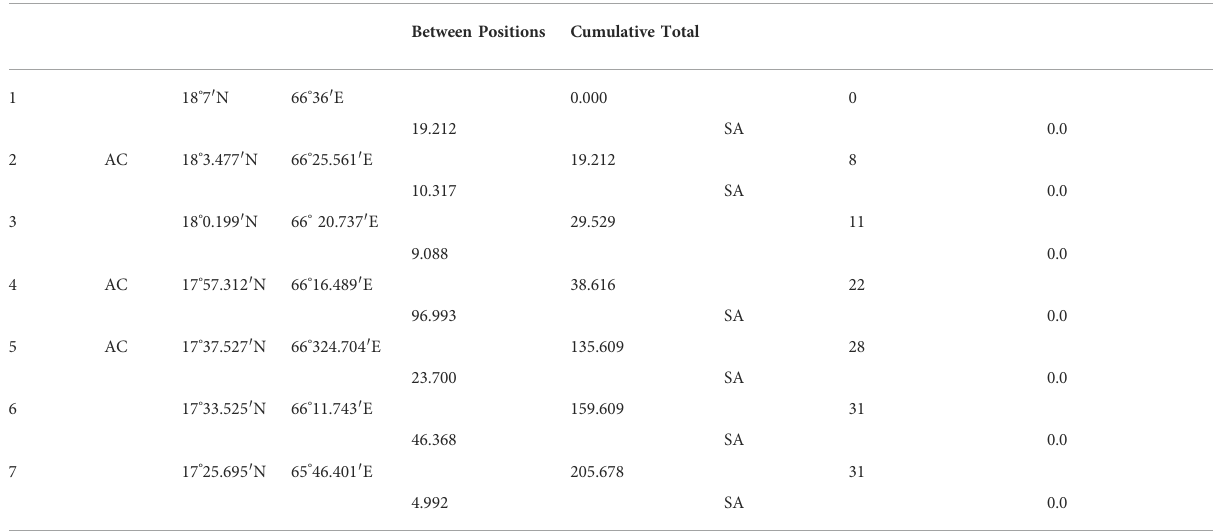
TABLE 1 Example RPL fi le.